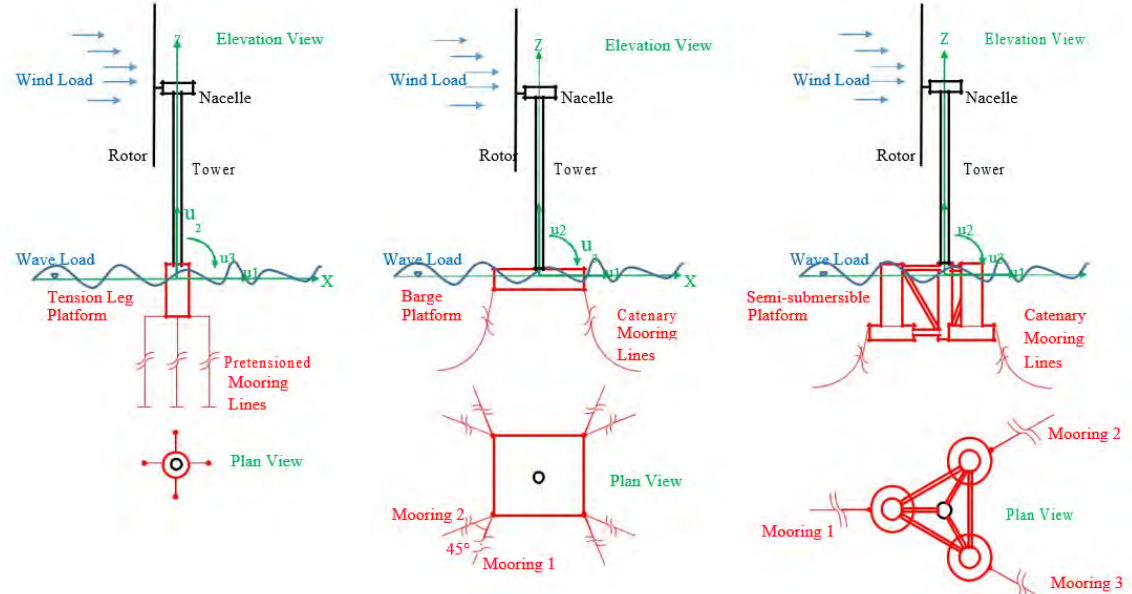
Figure 4. Limited DOF Model of NREL 5MW wind turbine on (from left to right) the MIT/NREL TLP, ITI Energy Barge, and OC4 DeepCWind Semi-submersible.